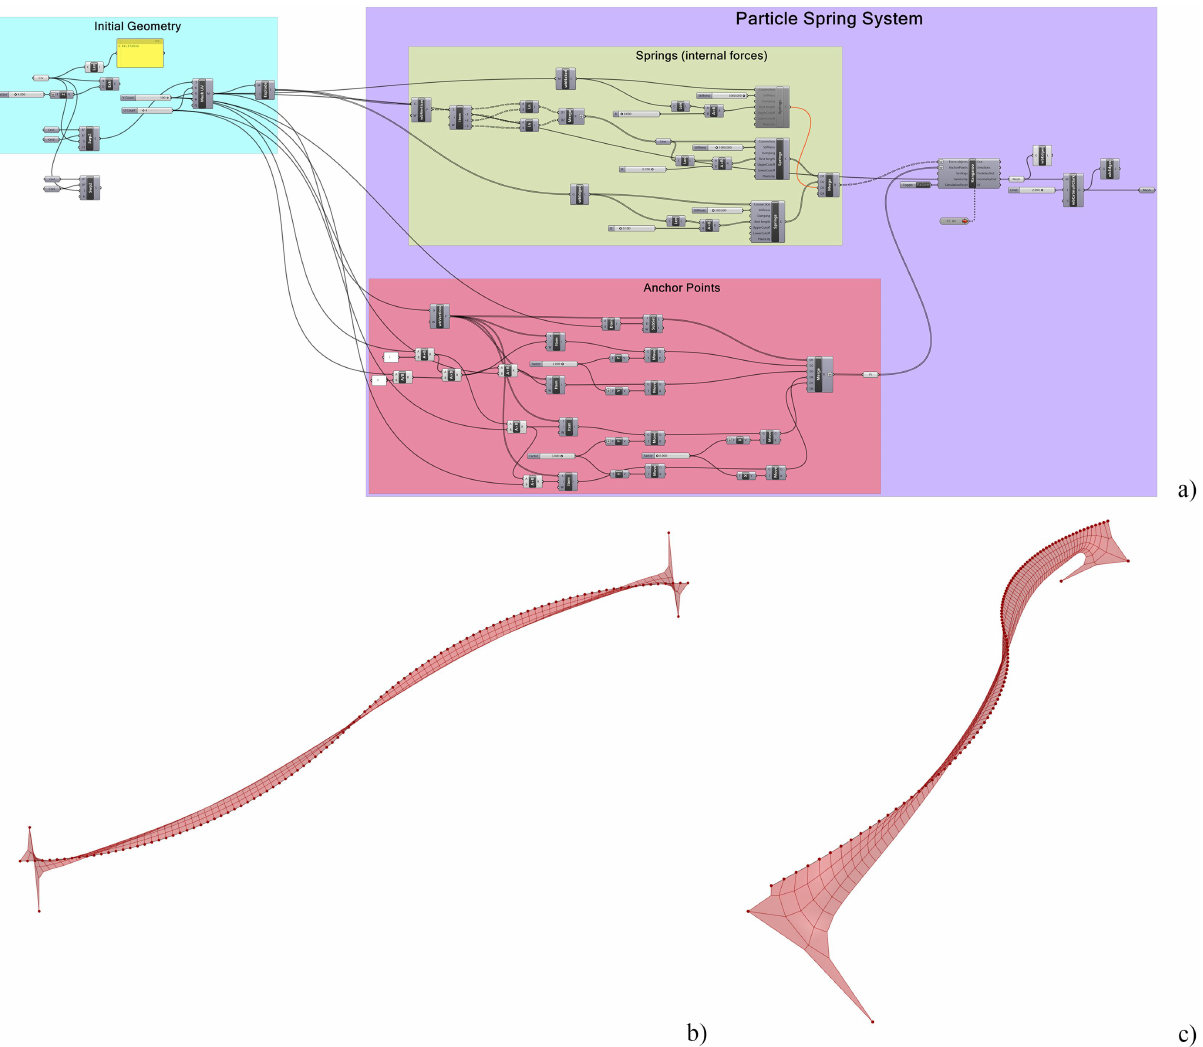
Figure 16: Form-finding by Particle-Spring System (PSS) of a S-curved curve and counter-curve shell: (a) Grasshopper/Kangaroo graphical form-finding algorithm; (b) top view of the optimal particle-spring network; (c) perspective view of the optimal particle-spring